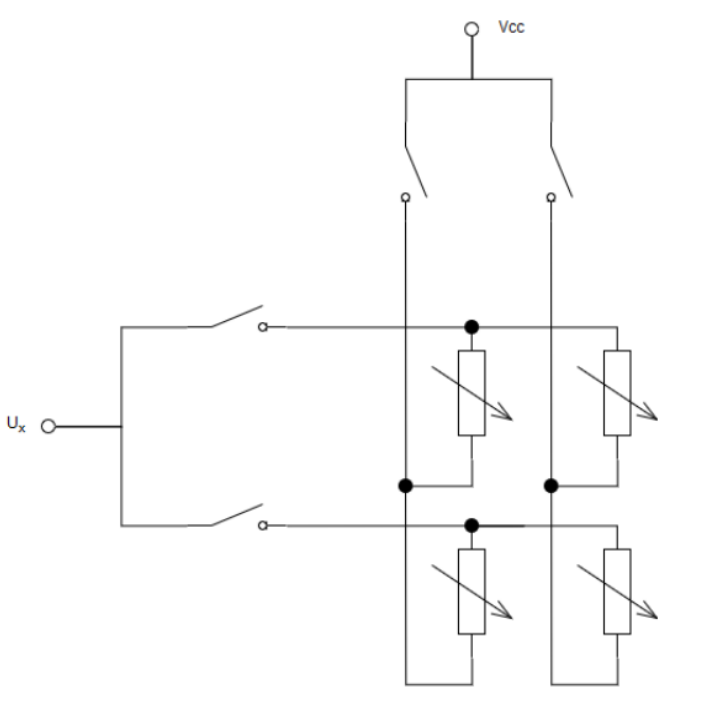
Figure 3. Measurement principle for FSR matrix of size 2 × 2.